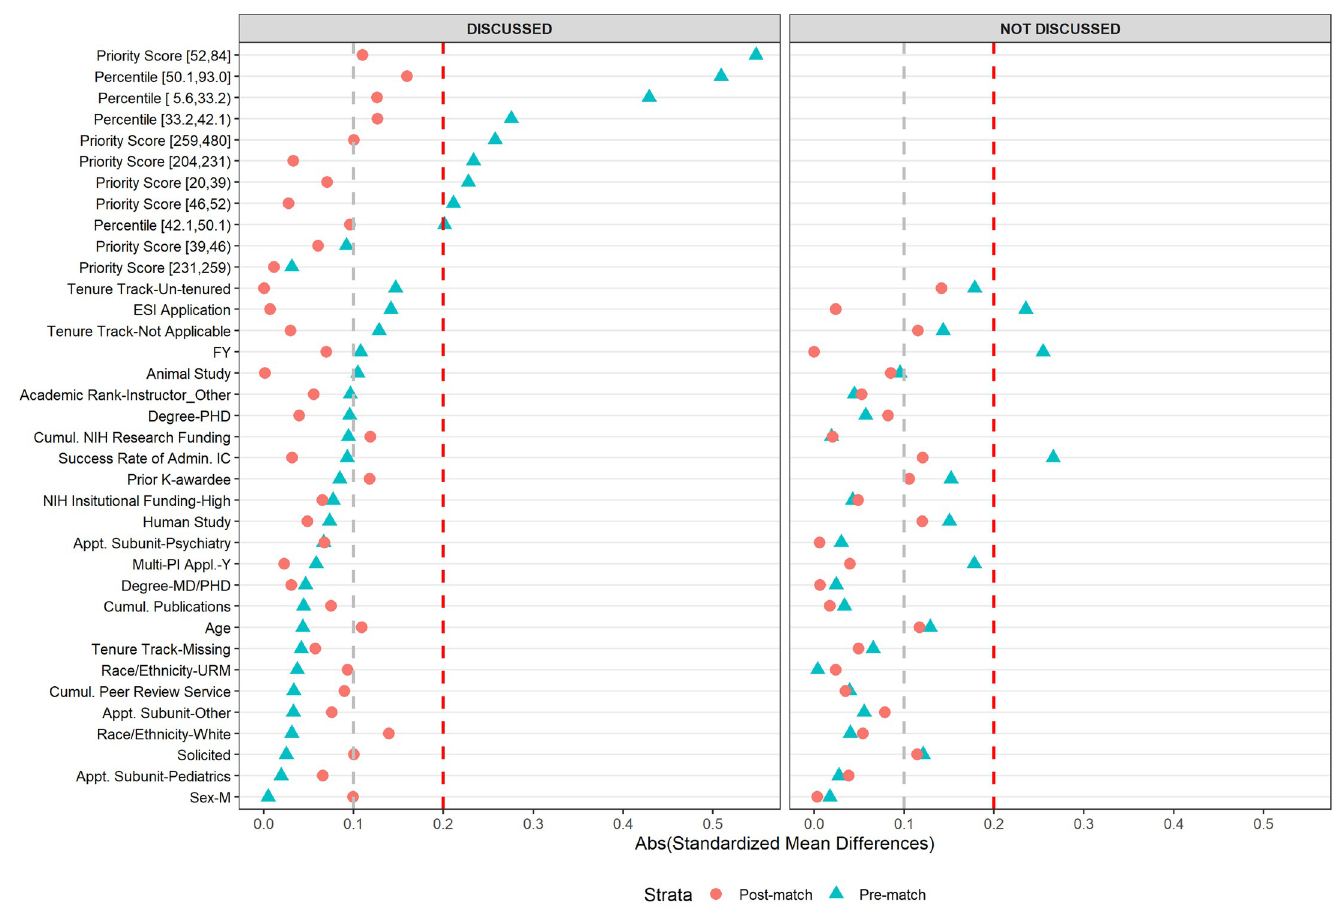
Fig 2. Love plots showing absolute standardized mean differences pre- and post- optimal full